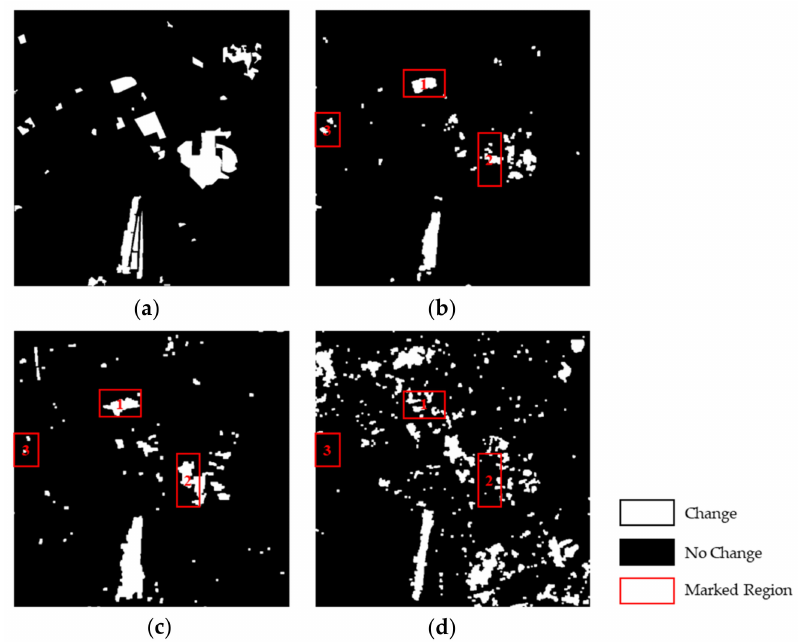
Figure 9. Final change detection results for Site 1: ( a ) ground-truth data, ( b ) result between Landsat-8 OLI images, ( c ) result between fused KOMPSAT-5 image and reference Landsat-8 OLI image, ( d ) result between KOMPSAT-5